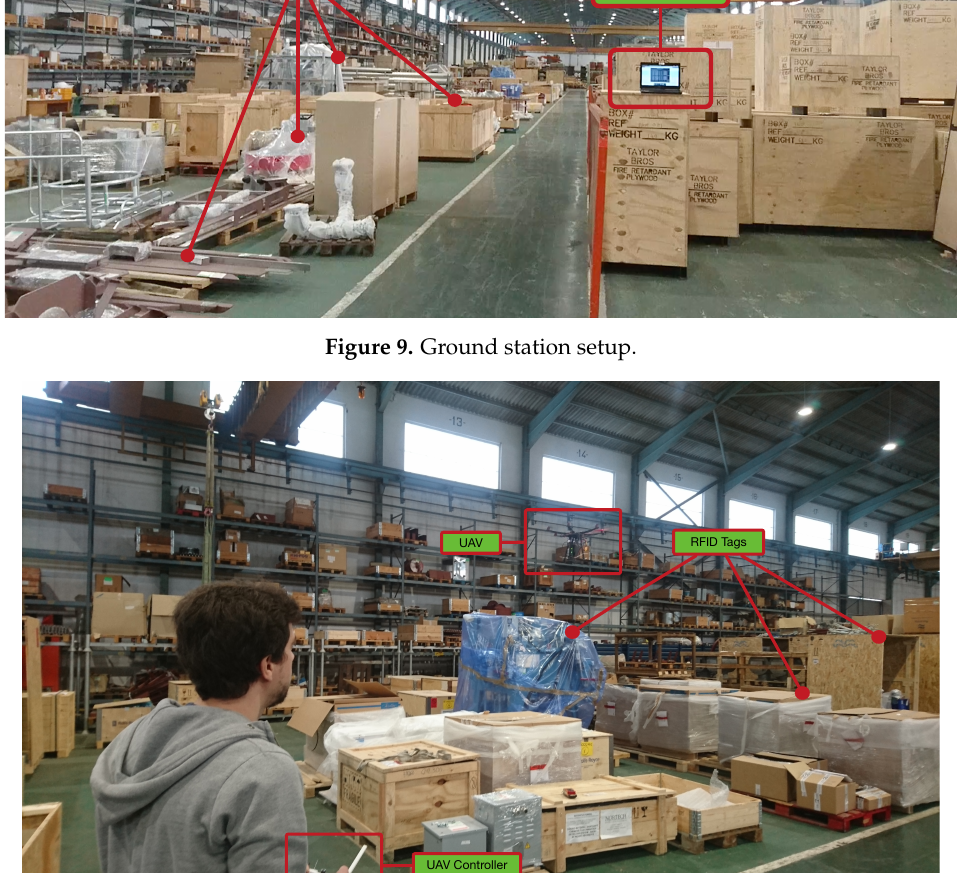
Figure 10. One of the instants during the inventory